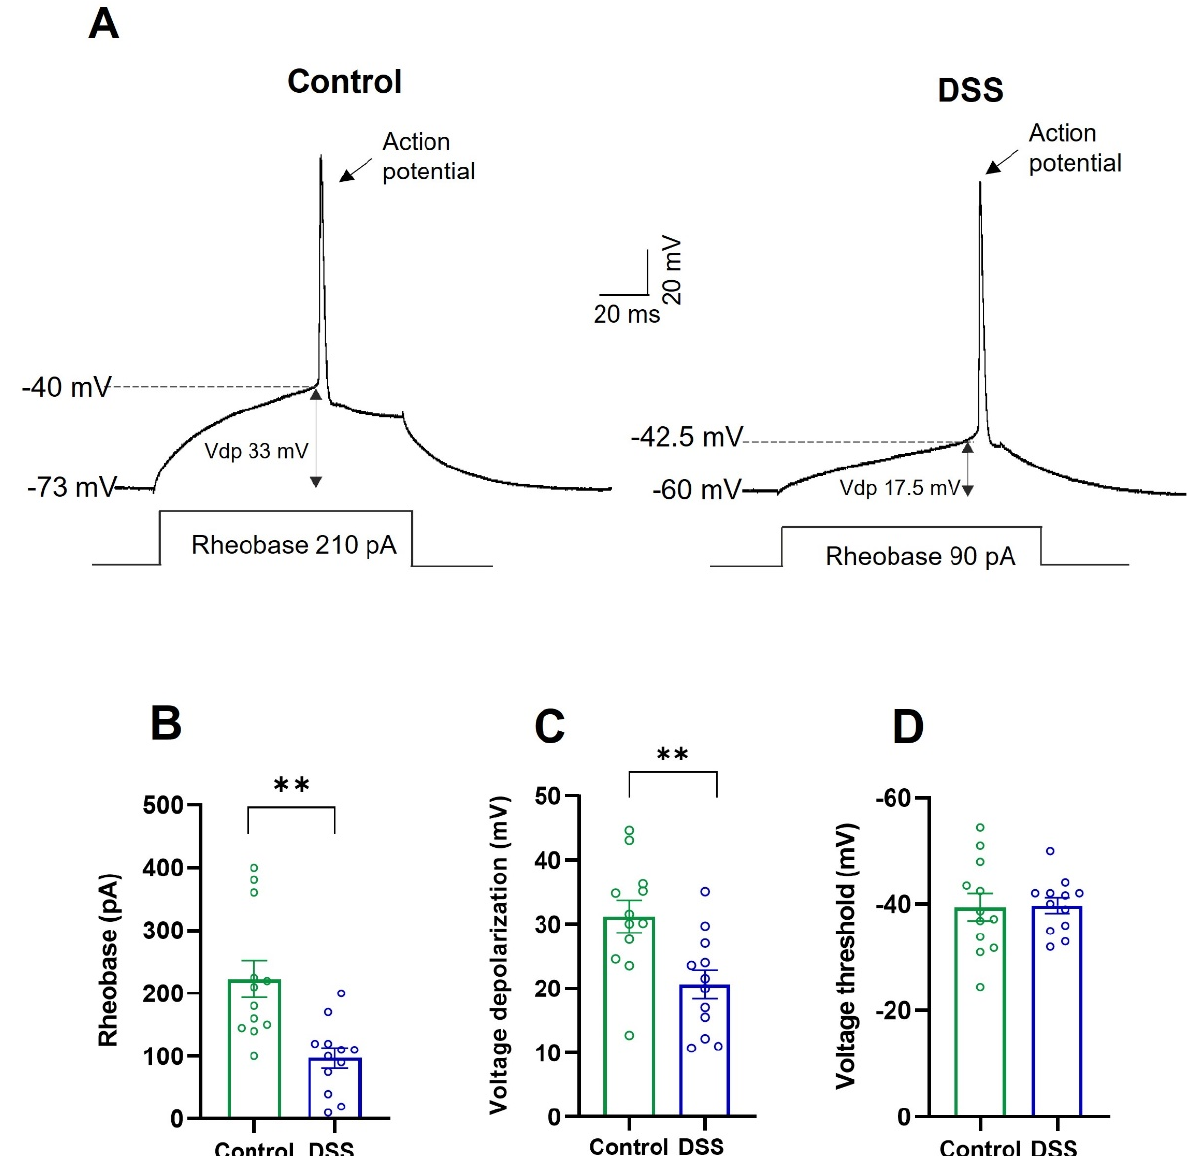
Figure 5. Rheobase and depolarization voltage of pyramidal neurons from the motor cortex of control and DSS-treated rats. ( A ) Membrane voltage responses to rheobase (minimum current required to evoke action potential) in a representative pyramidal neuron of control and DSS-treated rats. Vdp: Depolarization voltage. ( B ) Rheobase (pA). ( C ) Depolarization voltage (mV). ( D ) Voltage threshold (mV). Data are means ± SEM. The number of animals was 4 for each experimental condition and